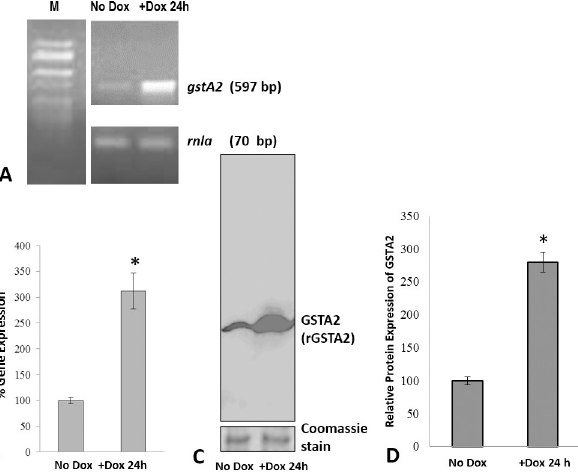
Fig 8. Analysis gstA2 expression in gstA2 -overexpression (DdGSTA2-OE) cells. (A, B) Semi-quantitative PCR analysis of doxycycline-induced expression in vegetative cells indicated a ~220% increase in the expression of gstA2 , which was confirmed by Western blotting using rabbit polyclonal anti-DdGSTA2 (C, D). M, molecular weight markers (50–2000 bp); rnla (70 bp). https://doi.org/10.1371/journal.pone.0250704.g008 assay conditions (pH 6.5) used to assess GST activity across many species, and the HL5 media (pH 6.4) used for axenic growth. According to Qin and coworkers [36], the pH for maximal activity of GSTs isolated from Locusta migratoria ranged from 7.0 and 9.0, which may relate to the alkaline internal environment after feeding. In another study [37], cytosolic GST activity from Corcyra cephalonica larvae is optimum at pH 8.3. Recombinant GST from Bombyx mori